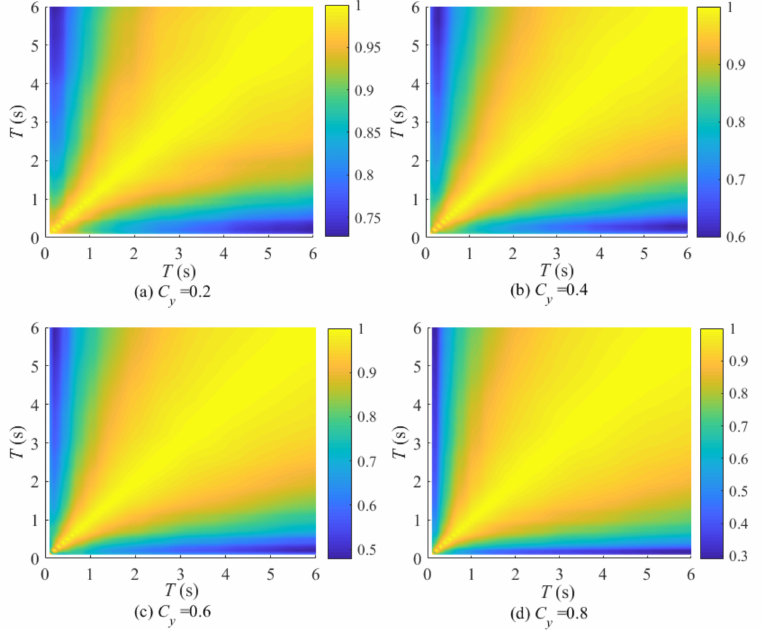
Figure 7. Correlation analysis of S d rankings at different periodic points (modified Clough